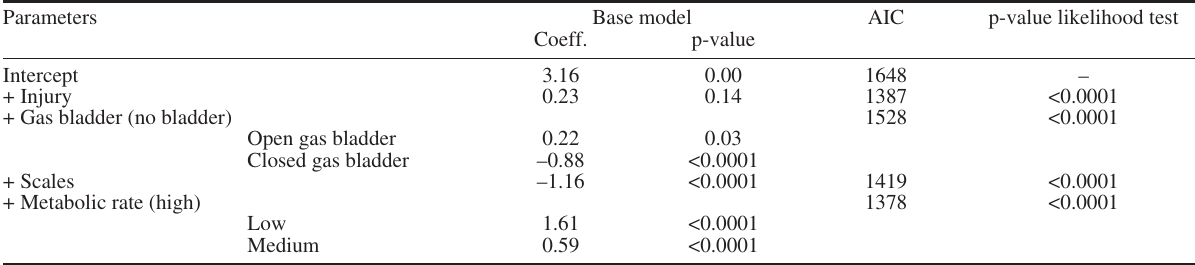
Table 5. – Coefficients, AIC and p-values from Weibull models of time-to-mortality for 12 species, without covariates (base model) and models including each biological trait as possible explanatory variable for time-to-mortality. Significance level α =0.05.